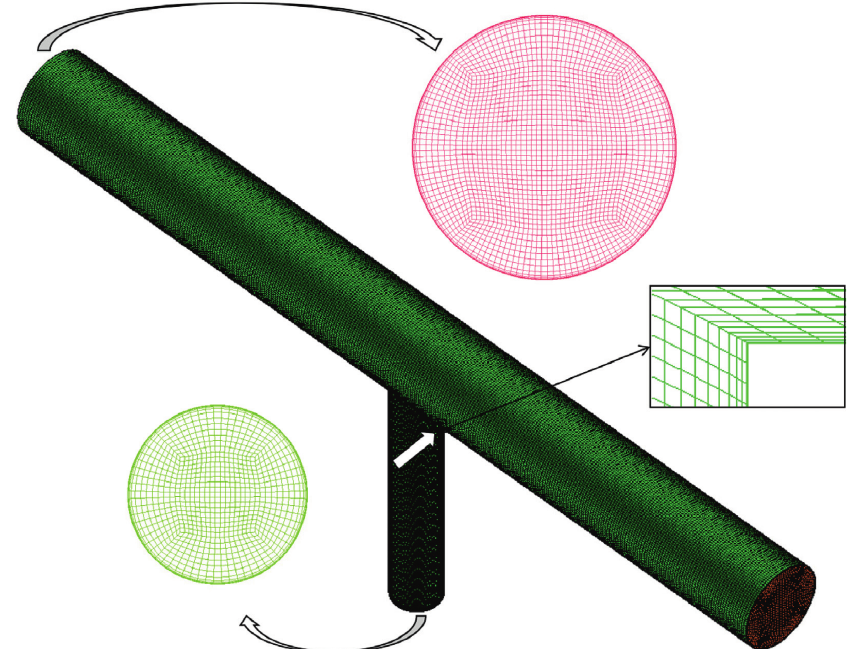
Figure 3: Grid area.